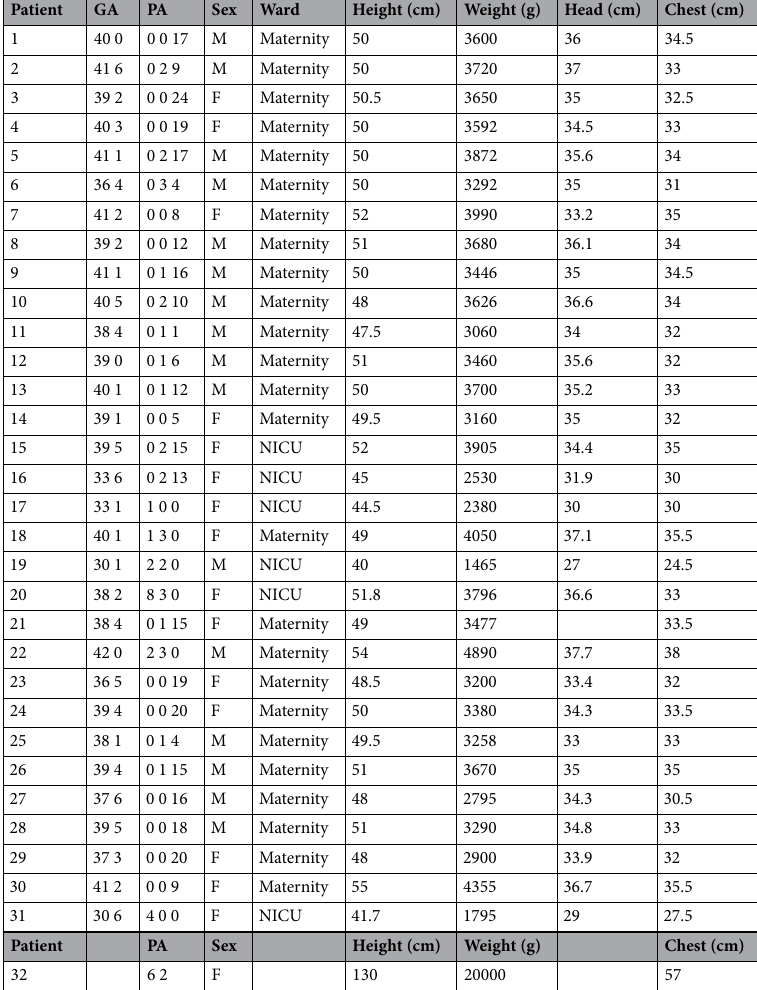
Table 1. Data of the recruited patients. GA is the Gestational age (weeks, days), PA is the Postnatal age (weeks, days, hours) for the newborns and (years, months) for the child. Sex is indicated as M for male and F for female. Chest value reported here was obtained by a standard tape